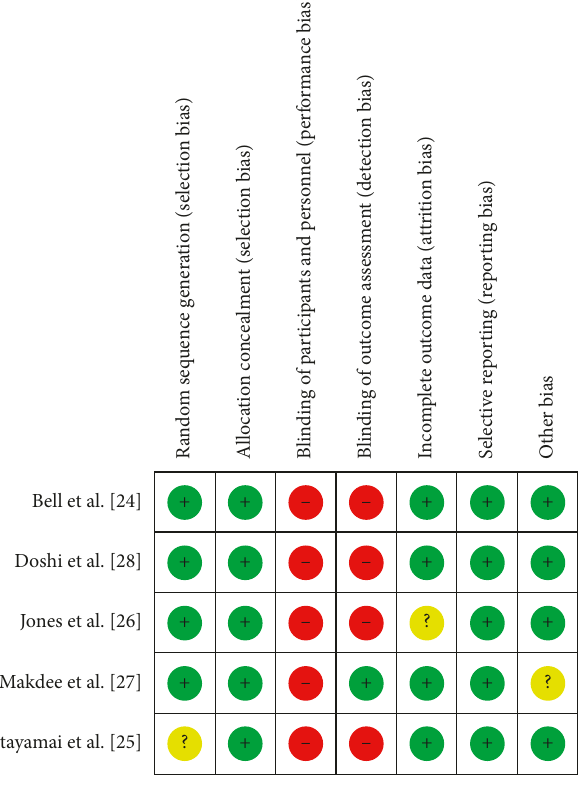
Figure 2: Risk of bias